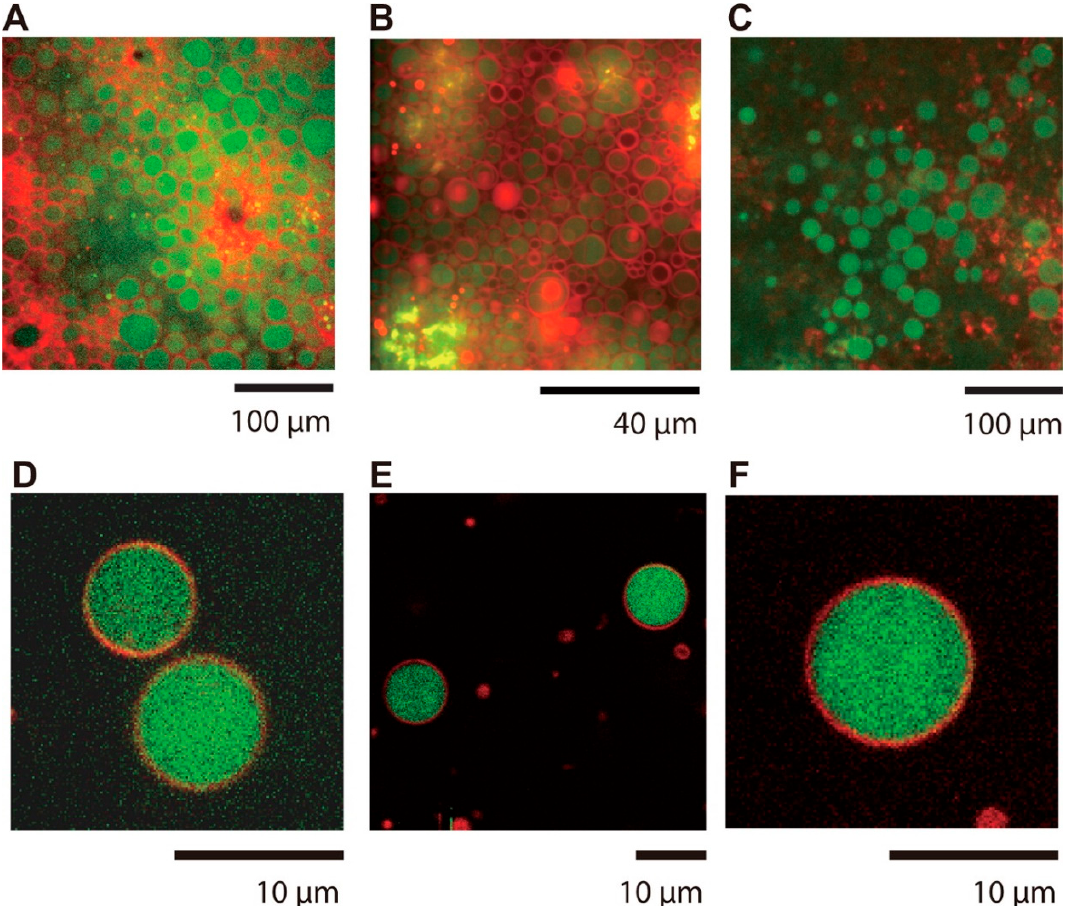
Figure 3. Phospholipid (red; Rho-PE stain) vesicles encapsulating DNA (green; YOYO-1 stain) on a surface ( A – C ) and after rehydration into solution ( D – F ). Scale bars as described ( A , D ) fragmented salmon DNA, ( B , E ) λ phage DNA, and ( C , F ) T4 phage DNA. Reprinted with permission from Shimobayashi, Shunsuke F., and Masatoshi Ichikawa. 2014. “Emergence of DNA-Encapsulating